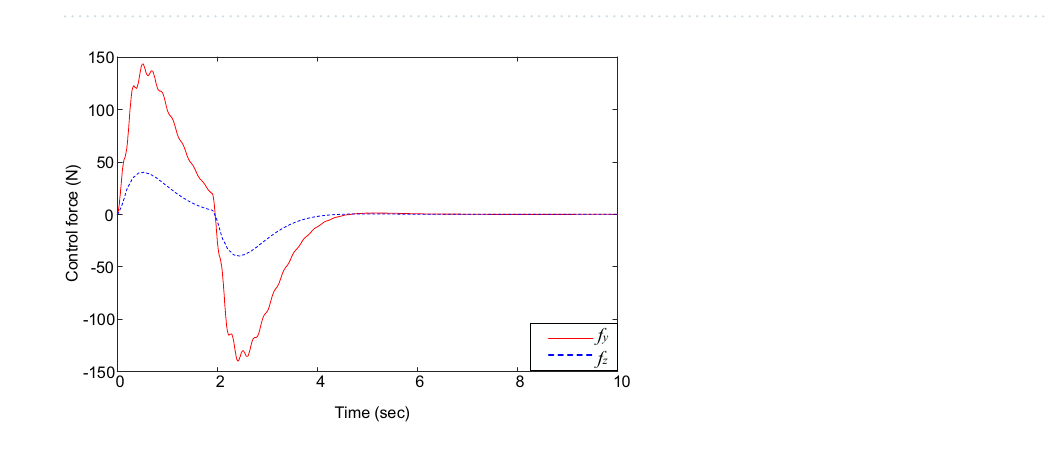
Figure 4. Control forces under the proposed control